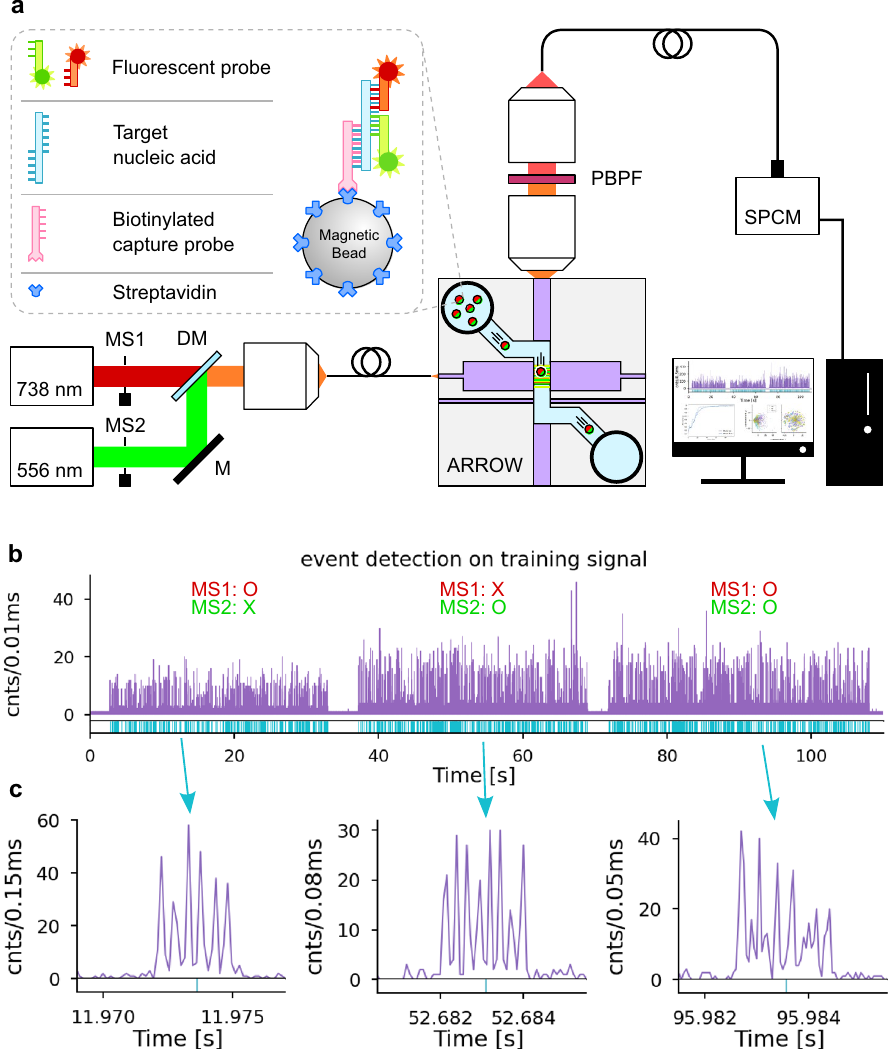
Figure 1. Experimental setup and dataset preparation. ( a ) Fluorescence signals are collected from labeled Klebsiella Pneumoniae bacteria captured on microbeads by a target-specific sandwich assay. Inset shows the sandwich design of the fluorescence probes, which consists of both green and red dyes. The sample is prepared off-chip and flows into the ARROW chip using negative pressure-driven flow. The multimode-interference (MMI) pattern formed at the MMI WG-analyte channel intersection is wavelength dependent and defines the signatures of different signals. The experiment is done in three steps depending on if beads are excited by the red laser, green laser, or both colors. Combinations of mechanical shutters (MS1 and MS2) are used to create the three mentioned stages. Fluorescence signals are collected off-chip through a penta-bandpass-filter (PBPF) to remove excitation photons. Emission photons are then detected and recorded on a PC by a single-photon- counting-module. ( b ) The recorded data trace (training signal) is analyzed by the PCWA program to detect events. Events are cropped and saved for dataset preparation. Locations of detected events are shown with blue markers. Event detection and cropping are done automatically. c Example events from three groups of